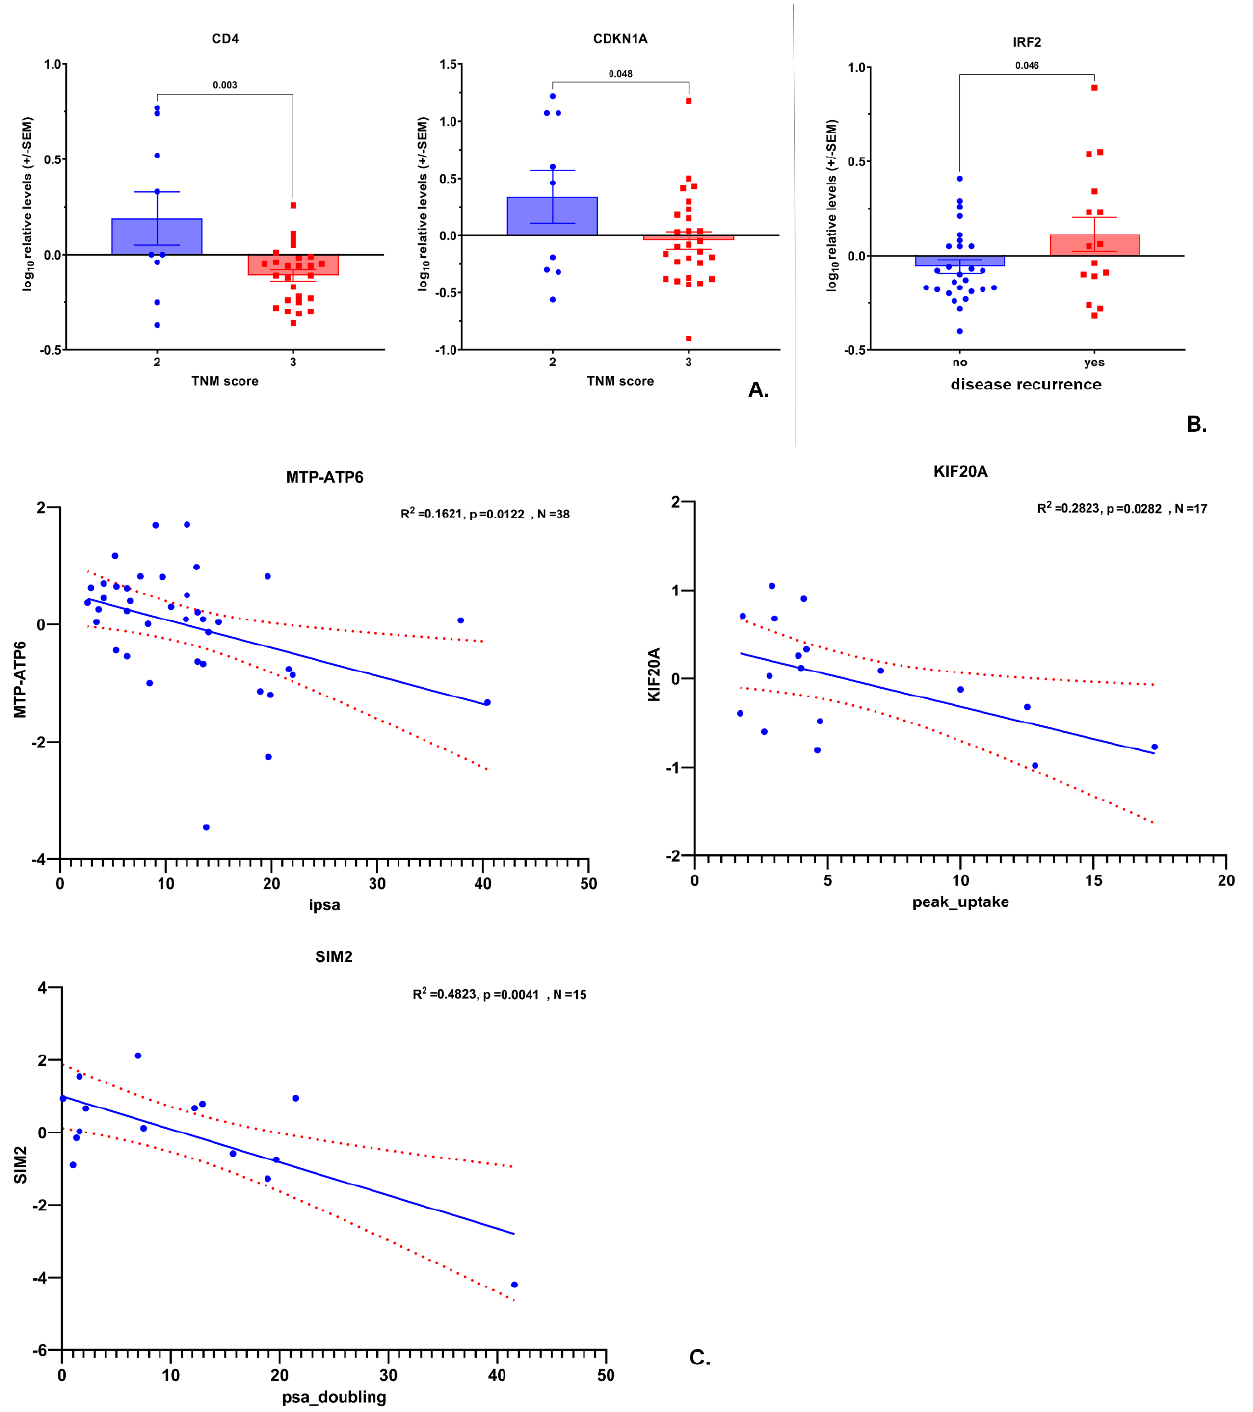
Figure A2. Significant associations and correlations between transcripts’ expression in blood-derived mRNA with TNM score, disease recurrence and standard clinicopathologic PSA-related variables in overall cohort, respectively. ( A ) Bar graph showing − log10 relative expression levels of gene transcripts in different TNM score groups or ( B ) log10 relative expression levels of IRF2 in groups with different disease recurrence. p value indicated after linear test for trend following ANOVA ( A , B ). ( C ) Scatter plots showing correlation between − log10 relative expression levels of gene transcripts (on the y -axis) and different clinical parameters (on the x -axis). Pearson correlation and R2 value are indicated, along with p values and N (number of observations/patients). In each graph, linear regression is denoted by the blue line and error bars are indicated by the red dotted lines.